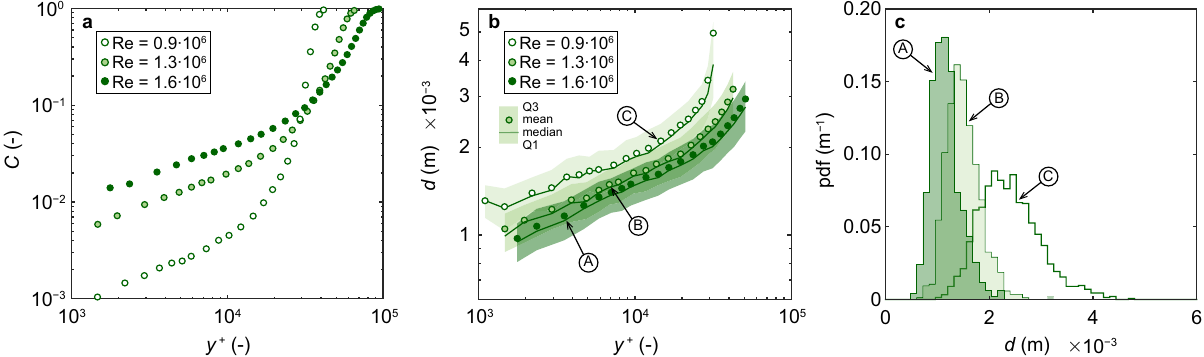
Fig. 2 Air – water fl ow properties for three Reynolds numbers. a Time-averaged void fraction C . b Sauter diameter d ; Q1, Q3 are the lower and upper quartile, respectively. to indicate locations for which Sauter diameter distributions are shown in ( c ).